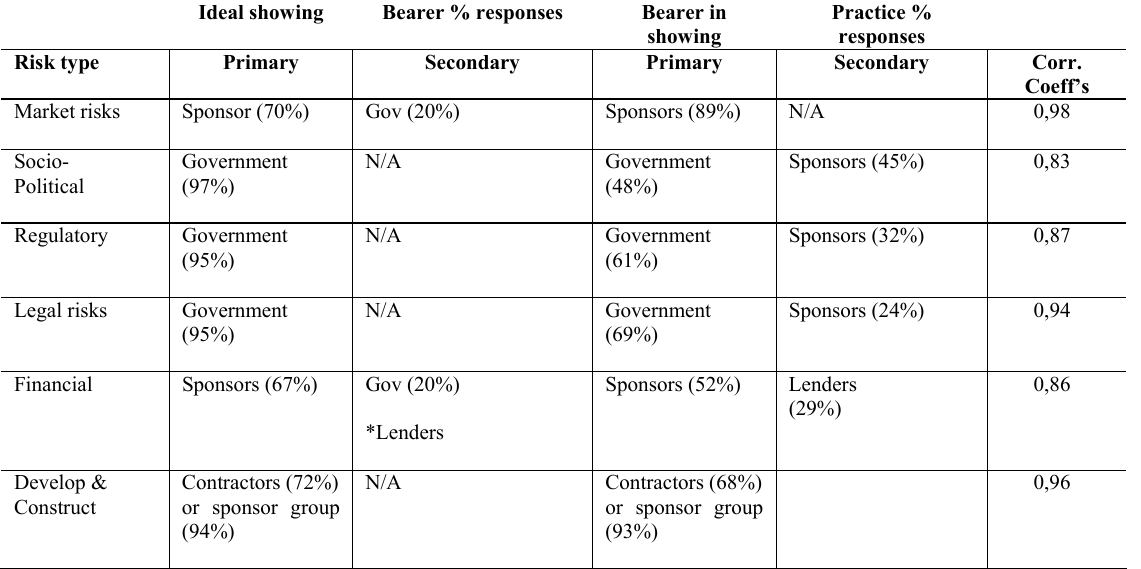
Table 7: Summary of ideal RA vs RA practice in South Africa Ideal